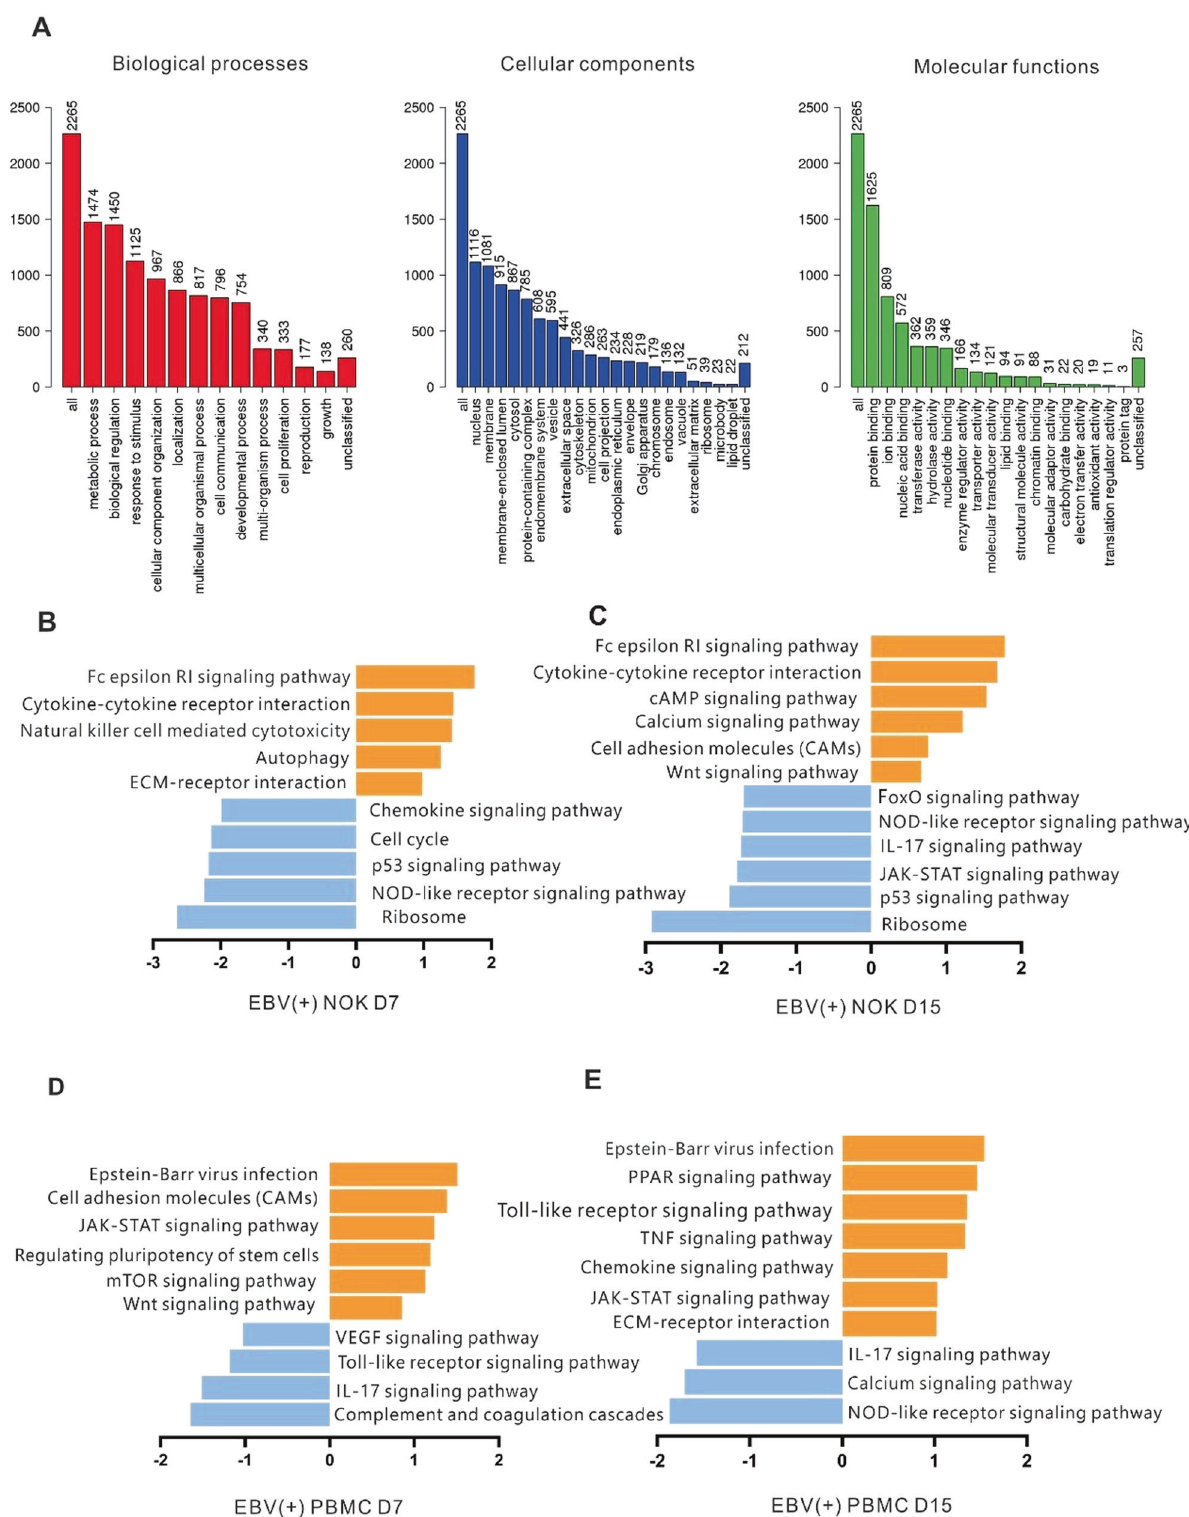
Fig. 4 Gene ontology (GO) and pathway analyses. Canonical pathways associated with human gene expression changes by RNA-Seq in infected NOKs and infected PBMCs at 7days and 15days when compared to the mock infected cells. A Gene ontology (GO) analyses. Bar charts are shown for GO Slim analysis terms for differentially transcribed protein-coding genes showing a change in both infected NOKs and infected PBMCs compared to no infected cells. B – E Gene set enrichment analysis (GSEA) for KEGG pathways identi fi ed from differentially transcribed protein-coding genes after BAC GFP-EBV infection. KEGG pathways are plotted against their average normalized enrichment score, showing upregulated (orange) and downregulated (blue) pathways. The width of the bars re fl ects the p -value, and the boxes re fl ect the ratio of the number of genes in the data set represented in the